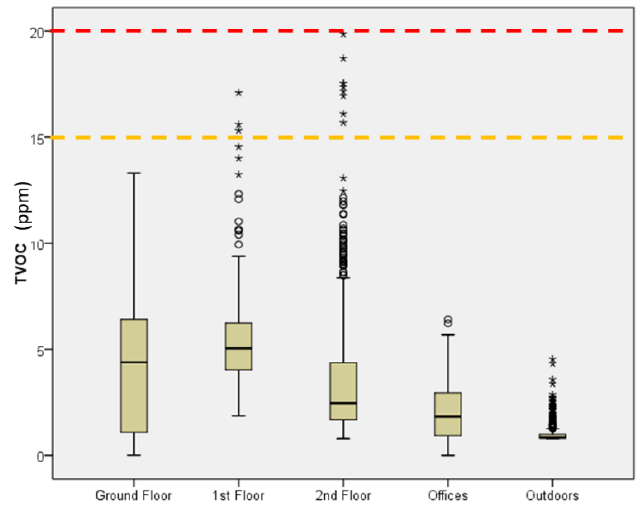
Figure 8. Total volatile organic compounds (TVOC) concentration in the museum premises for the entire measurement period. ‘’*’’ symbol is used for the outliers.